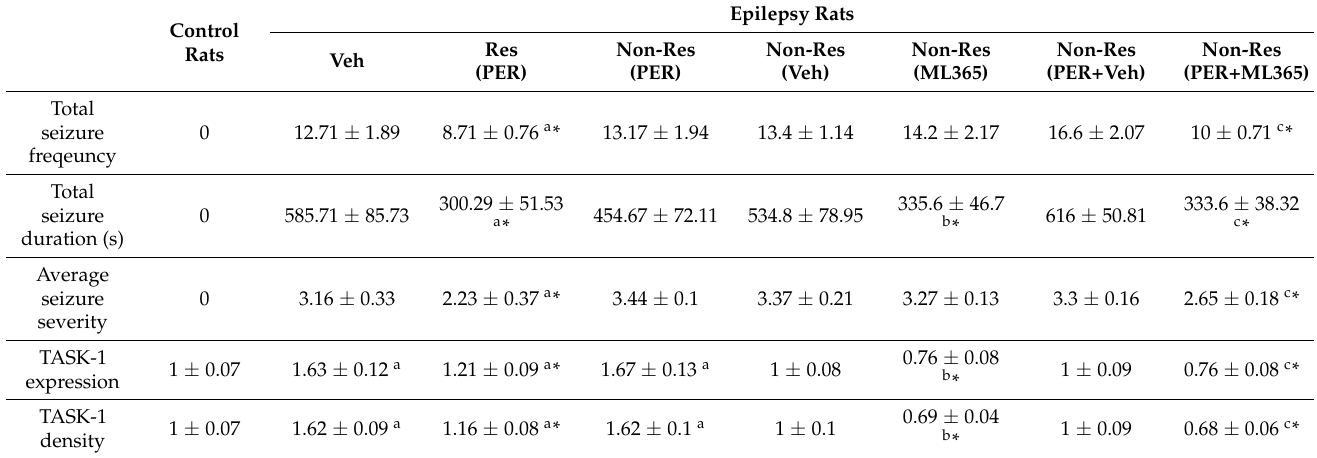
blot (* p < 0.05 vs. perampanel-treated animals). Table 1. Summary of the values of each treatment in the present study (mean ±